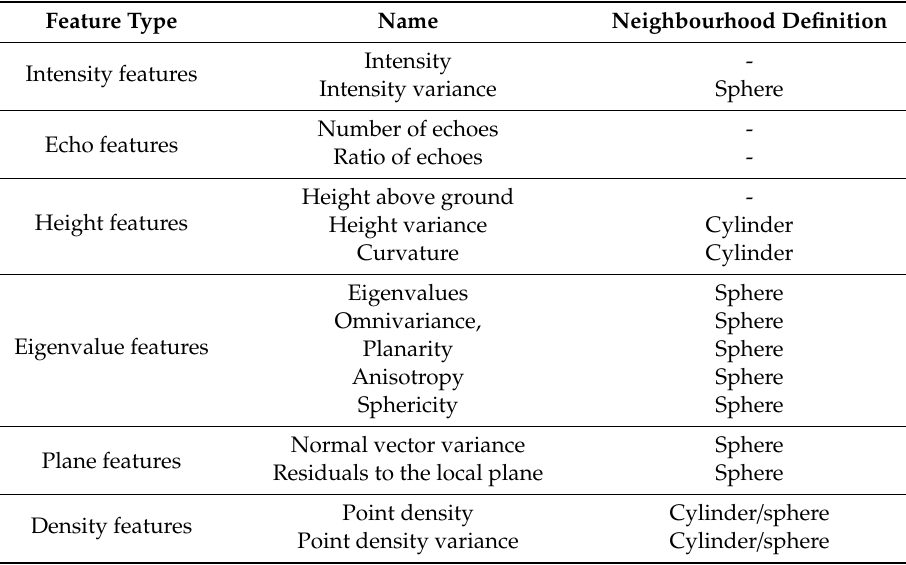
Table 1. Synthesis of LiDAR features for initial